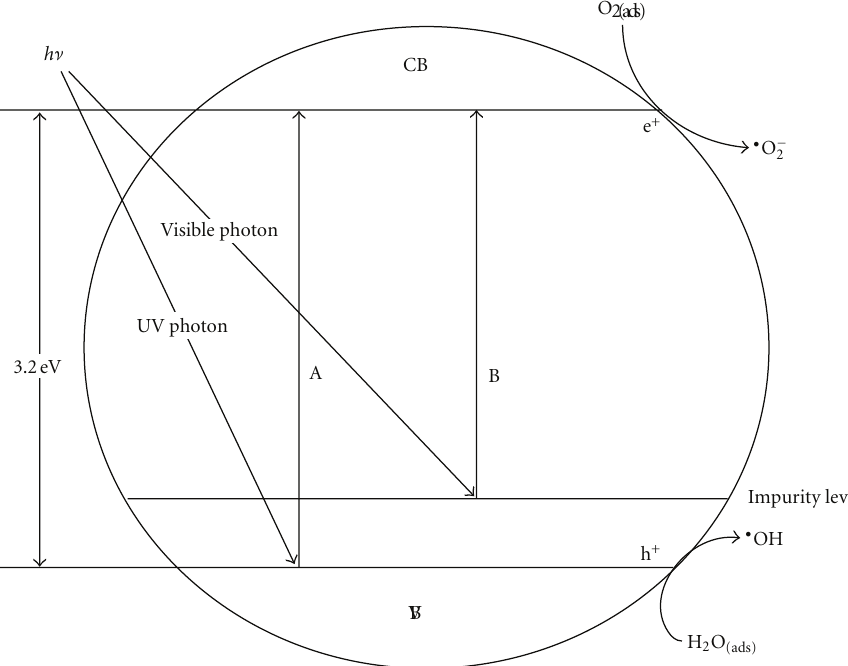
Figure 5: Scheme of photocatalytic mechanism of N-Cl-codoped-TiO 2